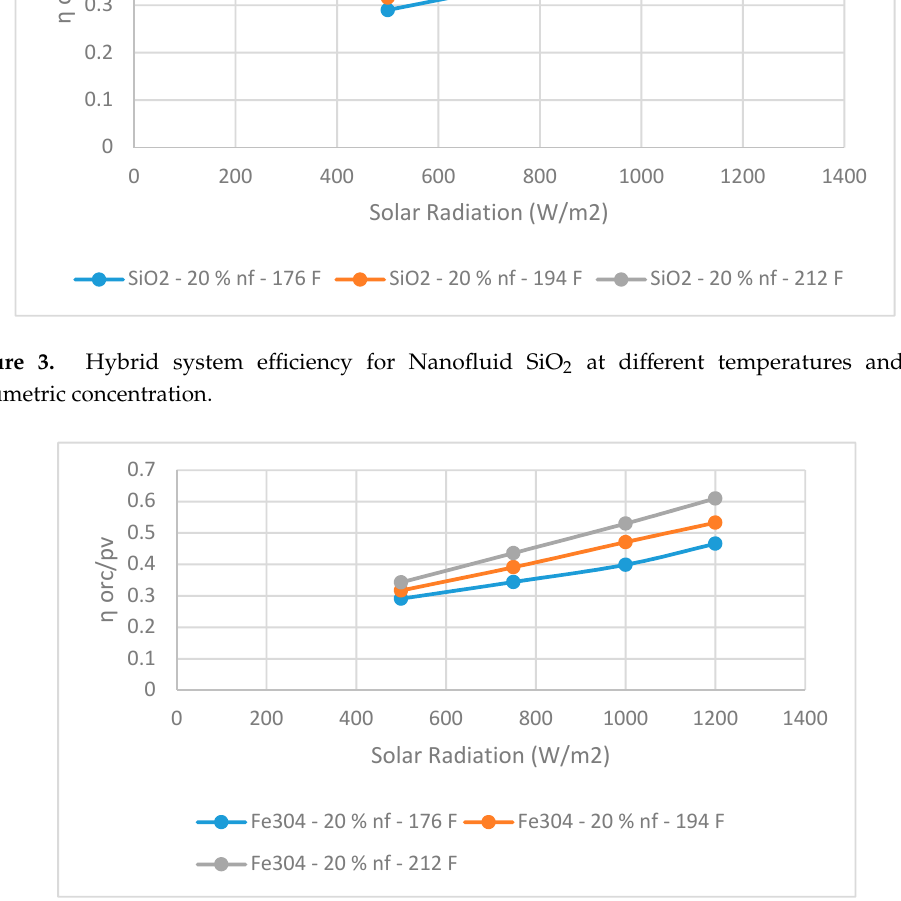
Figure 4. Hybrid system efficiency for Nanofluid Fe 3 O 4 at different temperatures and 20% volumetric concentration.